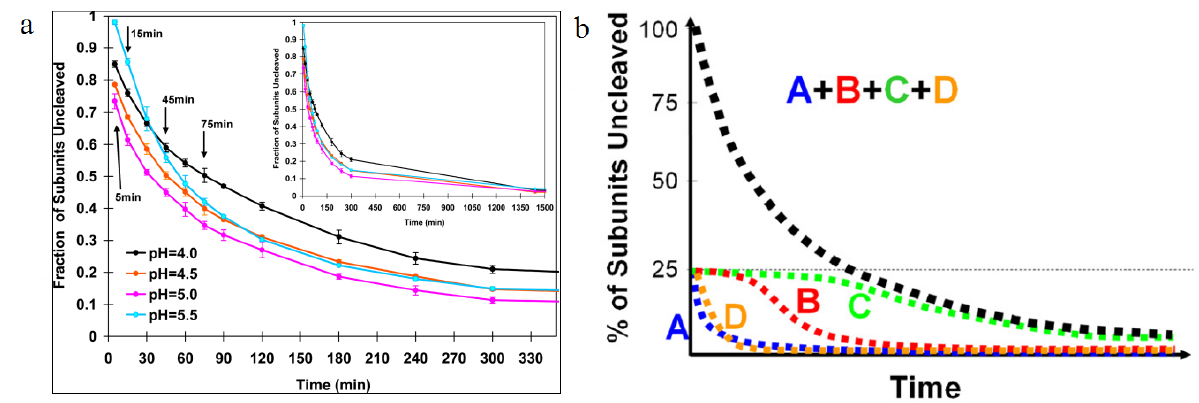
Figure 7. Autoproteolysis rates as a function of time. ( a ) The first appreciable amount of cleavage is observed 10 min after lowering the pH from 7.6 to 5. Half the subunits are cleaved at 30 min, then the cleavage slows dramatically; ( b ) A cartoon representation of cleavage as a function of time for individual subunits. Using difference maps from cryoEM experiments, the cleavage rate of individual subunits was determined. A and D subunits were shown to cleave quickly, with B and C subunits taking longer time to cleave, showing the dependence of subunit cleavage on the quaternary environment. Reproduced with permission from Matsui et al . [28].